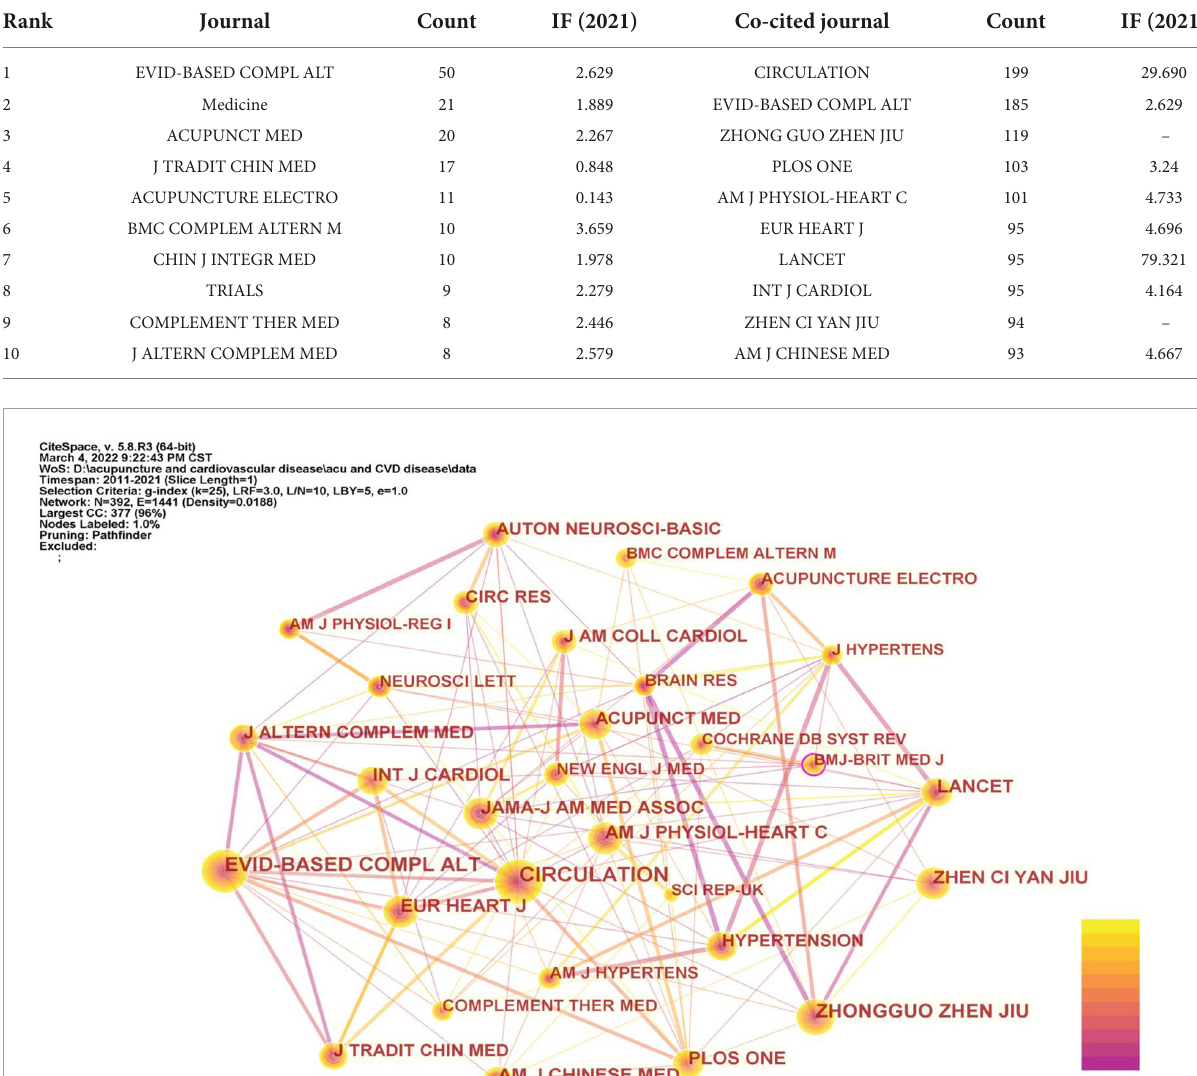
TABLE 5 The top 10 popular journals and cited journals.